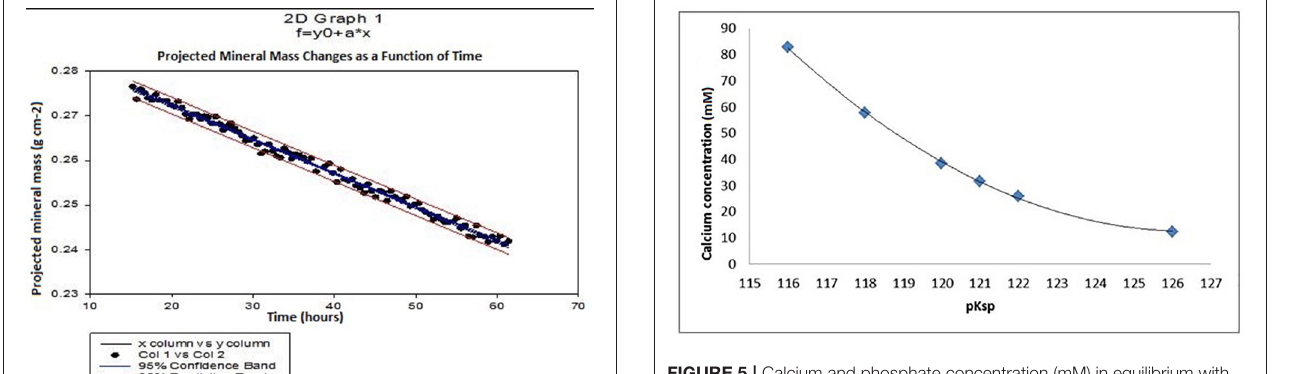
FIGURE 5 | Calcium and phosphate concentration (mM) in equilibrium with HAp as a function of the pKsp assumed for HAp, assuming pH = 4.0, 0.1M acetic acid, and 25 ◦ C as calculated by Chemist.